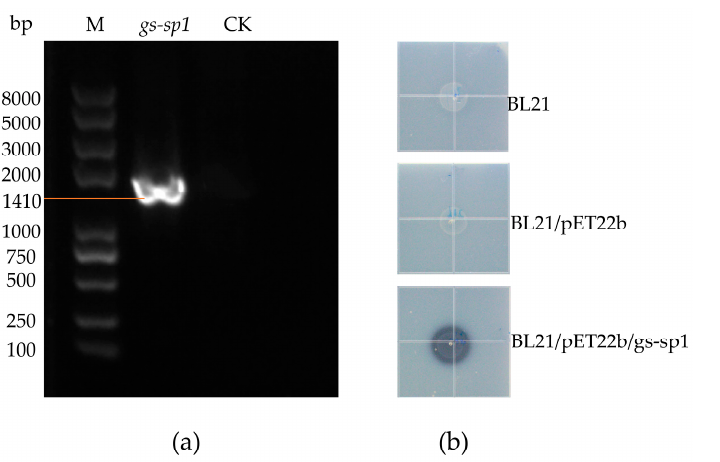
Figure 6. pET22b/gs-sp1 recombinant vector and protease activity observation: ( a ) PCR validation of the pET22b/gs-sp1 plasmid, M: Trans2K Plus DNA Marker; ( b ) after the strain was induced